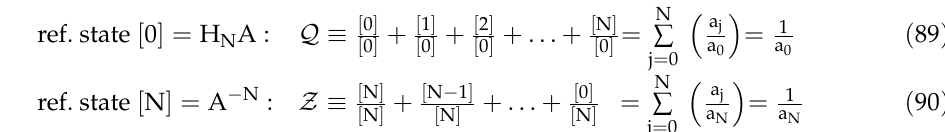
Monoprotic acids are special. The two probability densities, shown as blue and red solid curves in the left diagram, are the same except for a minus sign: